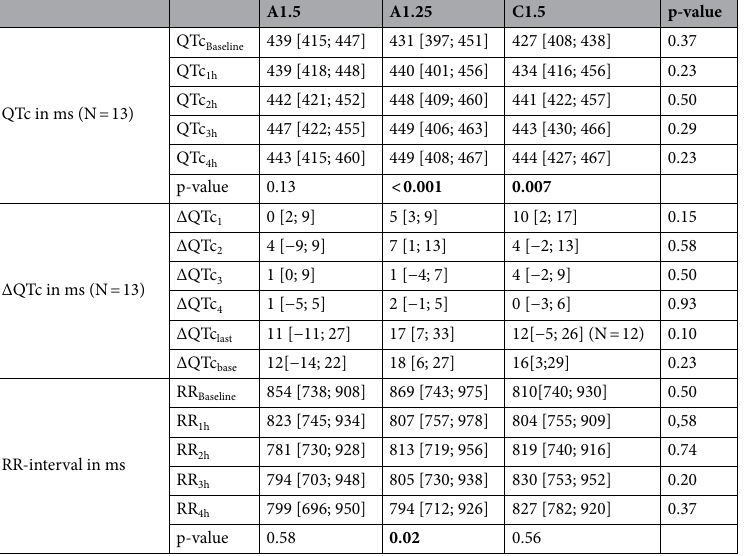
Table 1. Overview of QTc and RR per dialysate. Data are expressed as median with [25th; 75th percentile]. p-value is calculated with Friedman test between and within dialysates. A1.50 acetic-acid dialysate with calcium concentration 1.50 mmol/l, A1.25 acetic-acid dialysate with calcium concentration 1.25 mmol/l, C1.50 citric-acid dialysate with calcium concentration 1.50 mmol/l, QTc Baseline QTc of the first median complex (first 2 min of haemodialysis). QTc 1h , QTc 2h , QTc 3h , QTc 4h median QTc- of respectively the first, second, third and fourth hour of haemodialysis, ΔQTc 1 , ΔQTc 2 , ΔQTc 3 , ΔQTc 4 delta QTc of respectively between the first hour and baseline, second and first, third and second, and fourth and third hour of haemodialysis. ΔQTc last = delta QTc between last complex and baseline, ΔQTc base delta QTc between QTc of fourth hour and baseline.